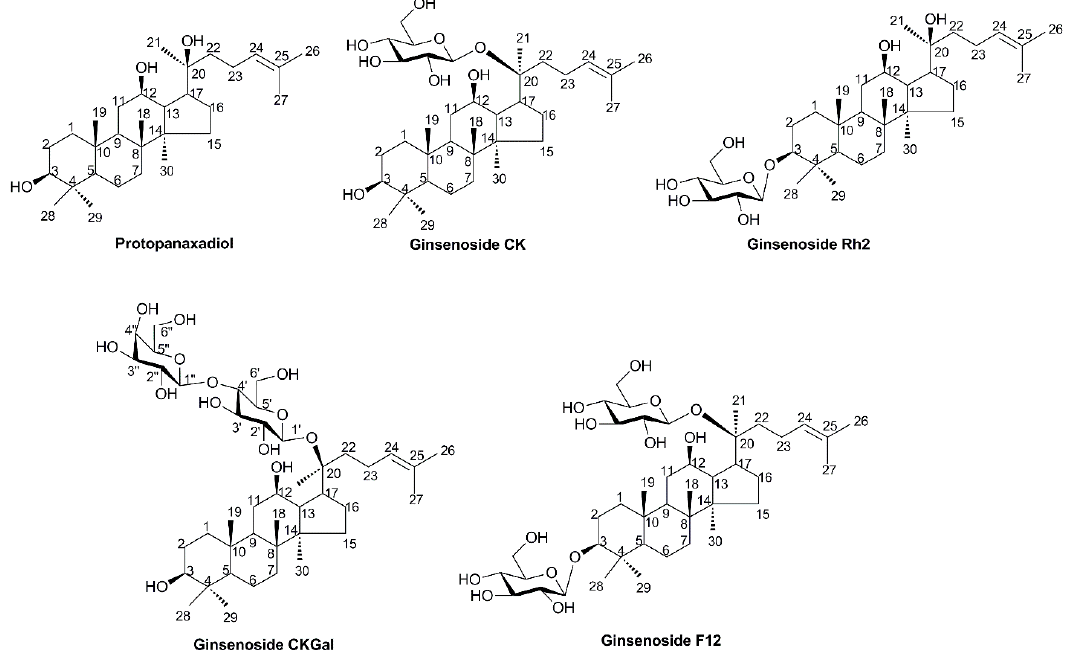
Figure 1. Chemical structures of the protopanaxadiol and ginsenoside derivatives of protopanaxadiol.